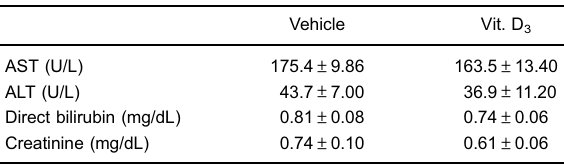
Figure 5. Lipid hydroperoxides ( A and B ), superoxide anion generation (SAG) ( C ), and hydrogen peroxide ( D ) levels in injured sciatic nerve ( A ) and spinal cord ( B – D ) of rats treated with vitamin D 3 (Vit. D3) (500 IU/kg per day) or vehicle for 7 or 28 days after chronic constriction injury (CCI). Rats were euthanized at 8 and 29 days post-surgery. Data are reported as means ± SE (n=6/group). a P o 0.05 compared to vitamin D-treated CCI rats at the same measurement time; b P o 0.05 compared to naive groups; c P o 0.05 compared to naive and sham groups (two-way ANOVA followed by Tukey ’ s post hoc test). For Sham rats, all surgical procedures involved in the CCI were used except the ligature.